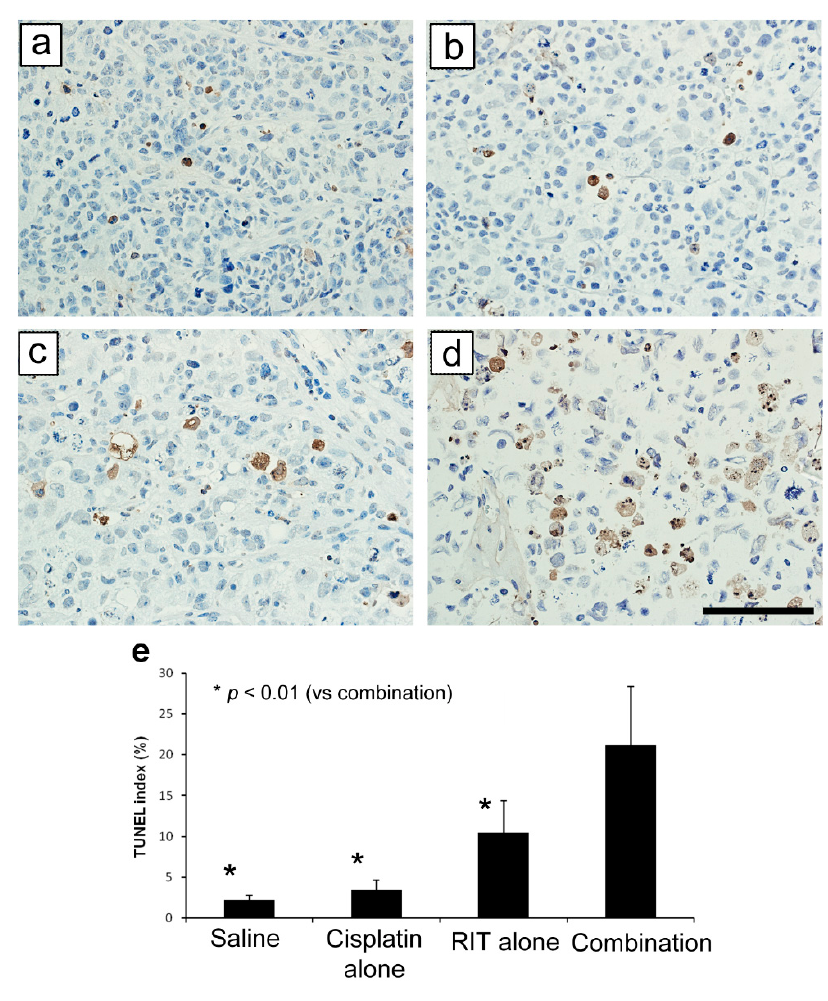
Figure 5. Day seven TUNEL analysis across distinct treatment groups (400× magnification, scale bar: 100 µm). ( a ) Control, ( b ) Cisplatin-only, ( c ) RIT-only, and ( d ) Combination therapy groups with associated TUNEL indices ( e ). * p < 0.01 (vs. combination group).